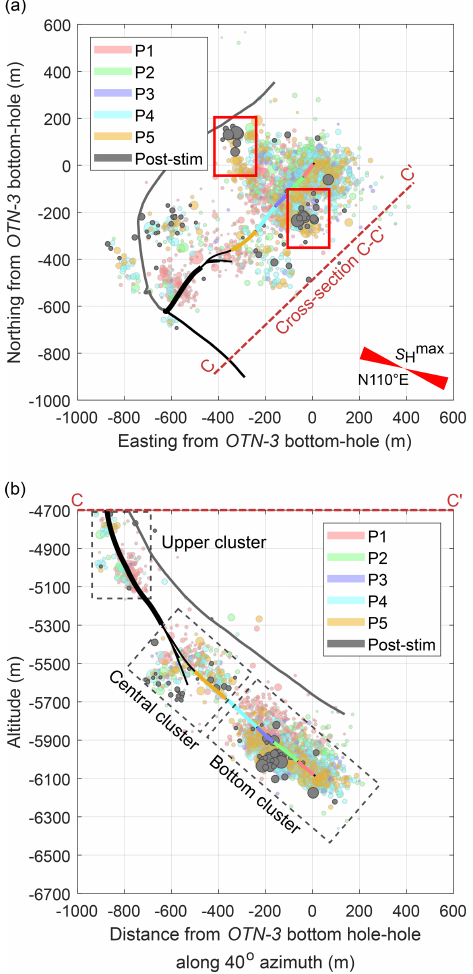
Figure 5. Temporal evolution of the cumulative seismic moment re- lease with time for each of the three hypocenter clusters separately: (a) the uppermost hypocenter cluster, (b) the central hypocenter cluster, and (c) the deepest and main hypocenter